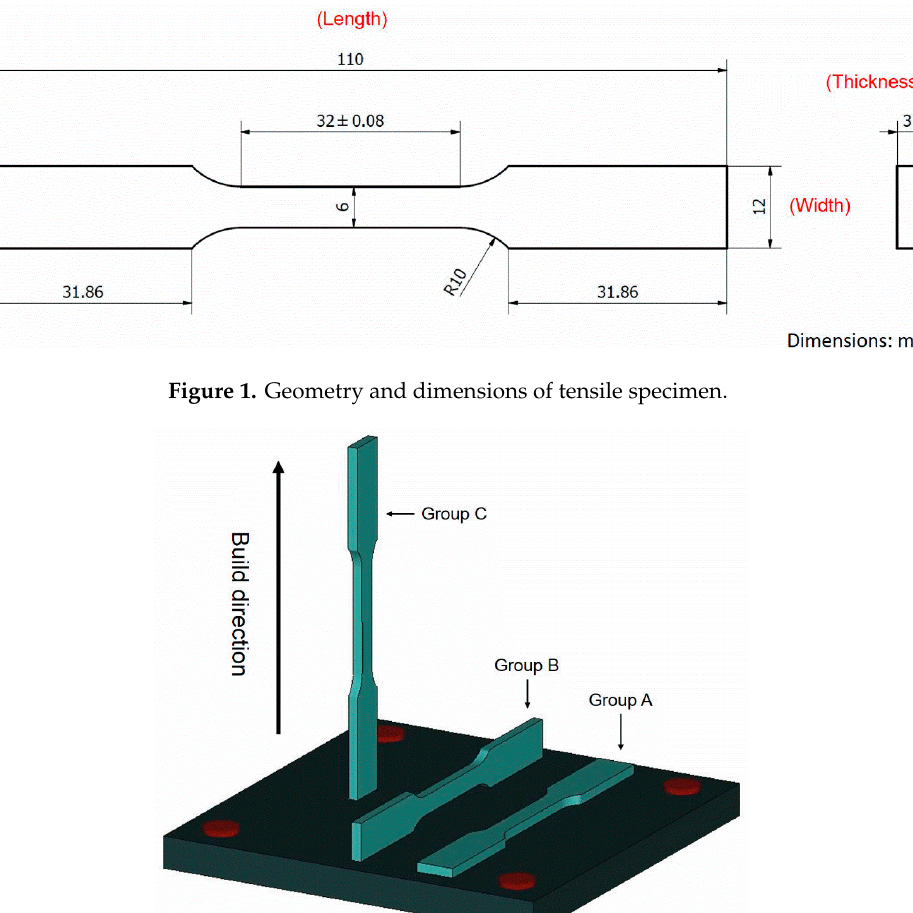
Figure 2. Schematic of build direction for each group of specimen.